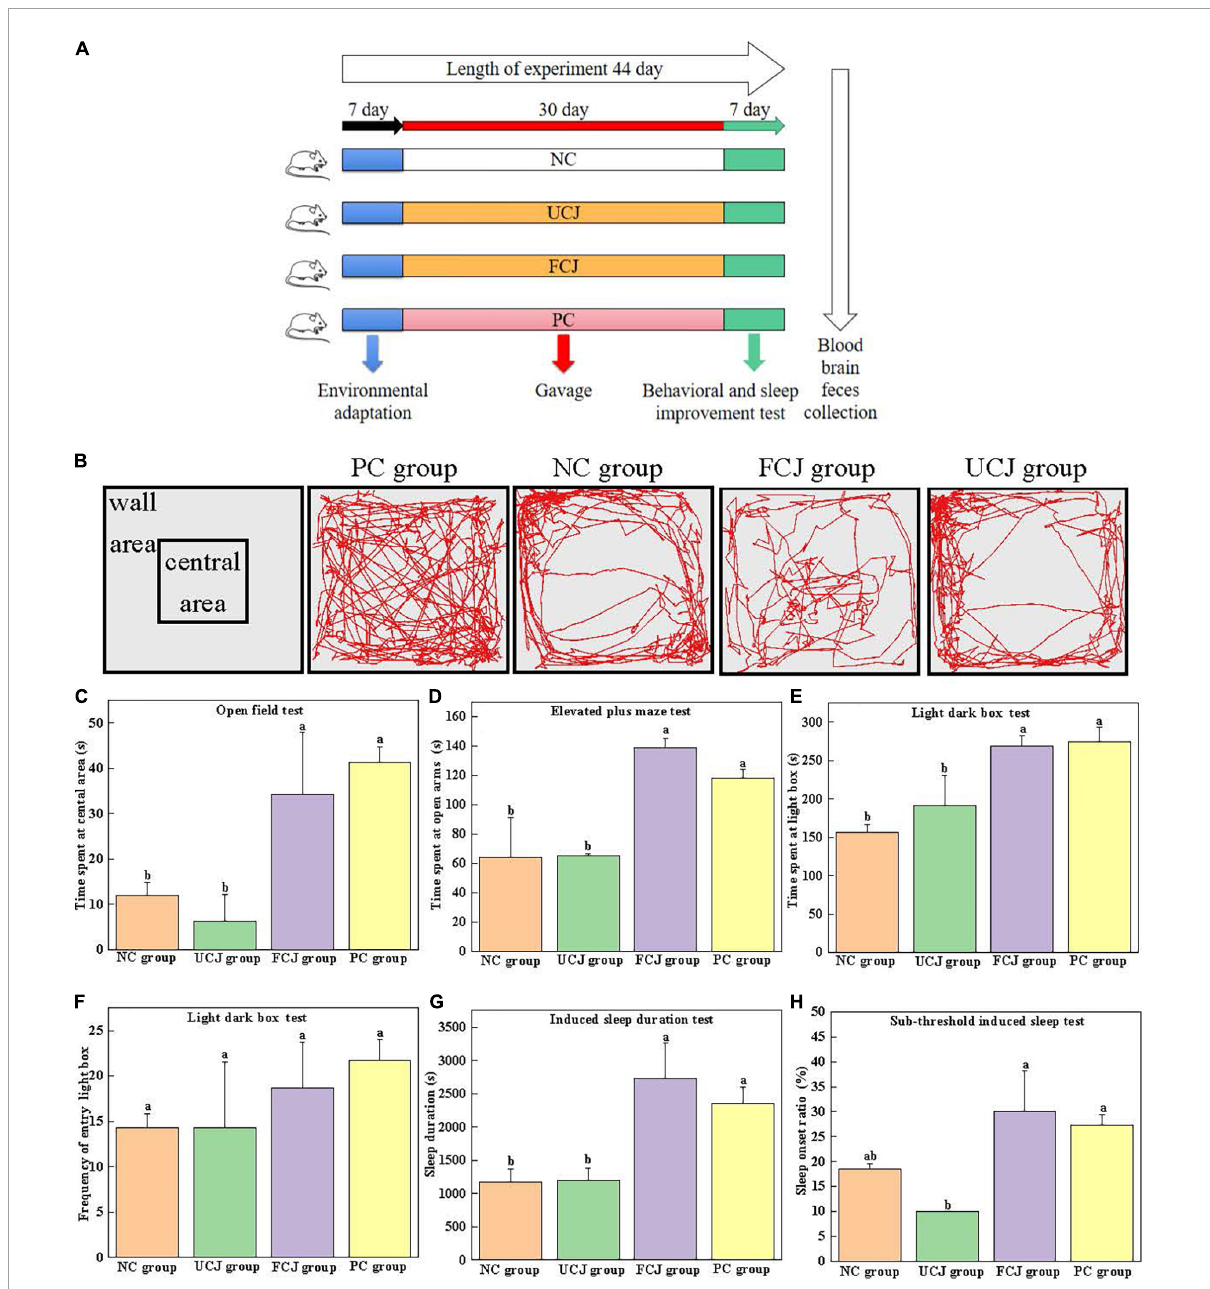
FIGURE1 Effects of control (NC) group, unfermented carrot juice (UCJ) group, fermented carrot juice (FCJ) group, and positive control (PC) group on behavioral test and sleep improvement test in mice. (A) Schematic representation of the experimental procedure; (B) captured images for OFT; (C) the time spent at the central area for OFT; (D) the time spent at open arms for EPM; (E) the time spent at light box for LDB; (F) the frequency of entry into the light box for LDB; (G) sodium pentobarbital-induced sleep duration test; (H) sub-threshold sodium pentobarbital dose-induced sleep test. Data are mean ± SEM ( n = 10). Different letters indicate significant difference ( p < 0.05).